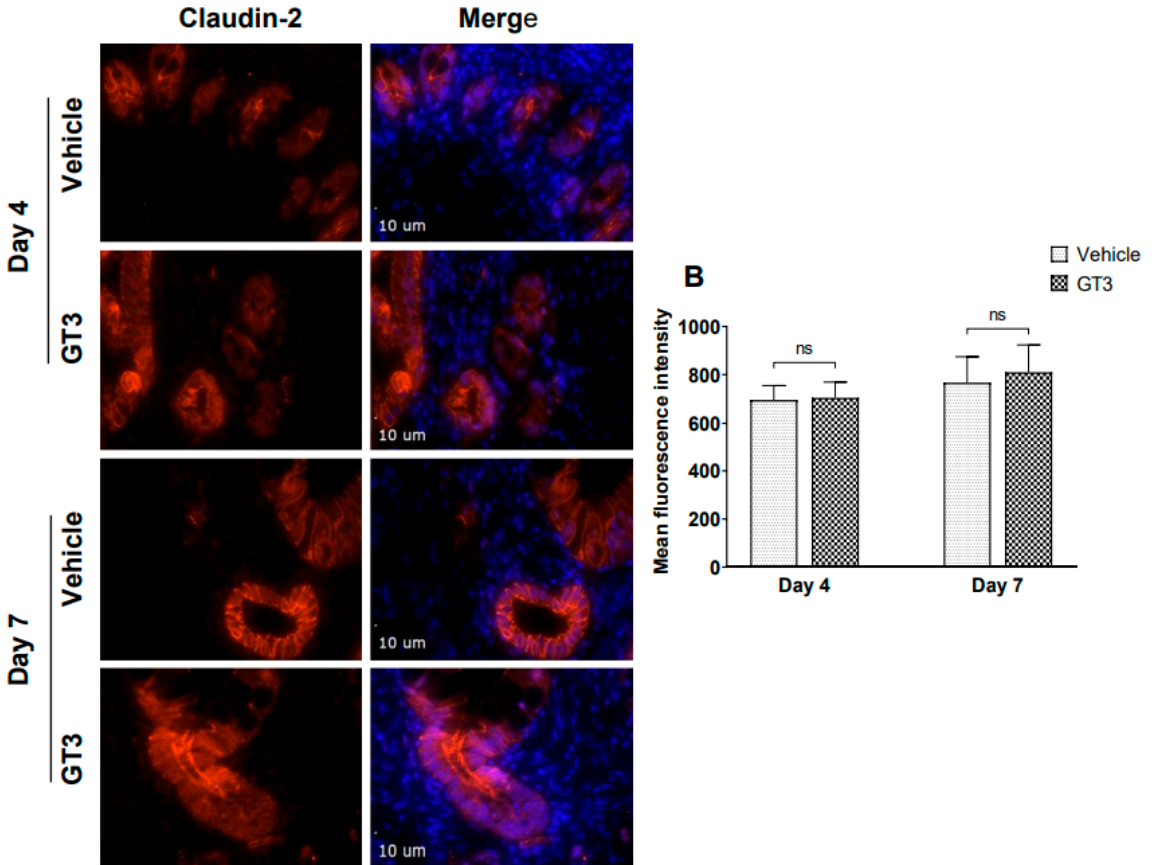
Figure 6. . Effects of GT3 on claudin-2 expression in intestine. ( A ) Representative photomicrograph of claudin-2 expression (red) in the cross sections of the intestine at day 4 and day 7 post-irradiation. ( B ) Quantitation of claudin-2 expression levels in intestinal crypts at indicated time points post-12 Gy TBI. The data are presented as average ± SEM; N = 3 (day 4) and N = 5 (day 7). ns = not significant.